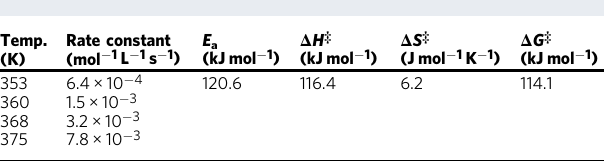
Table 3 Kinetic parameters of the one-step oxidation reaction a . Temp. (K)